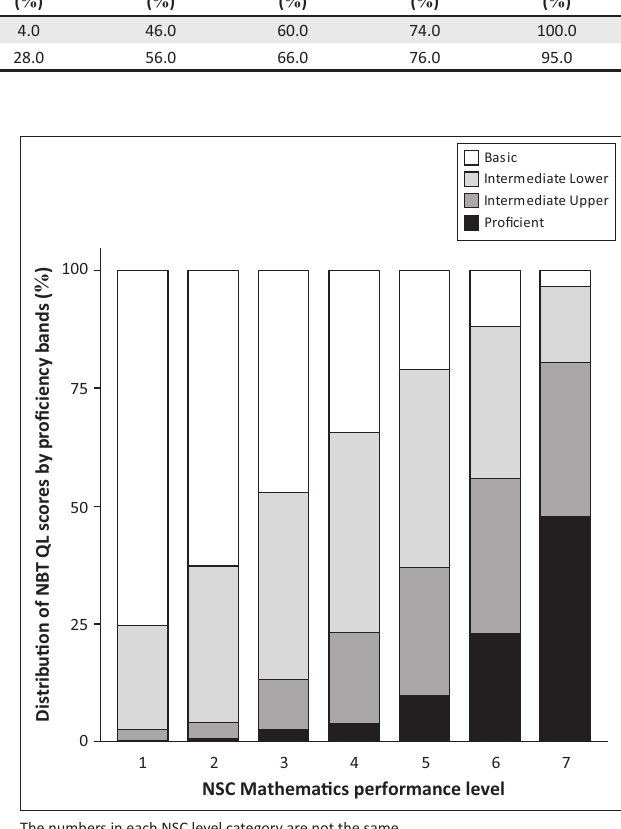
FIGURE 5: Percentage distribution of National Benchmark Test quantitative literacy scores by proficiency band for different National Senior Certificate Mathematics levels achieved.